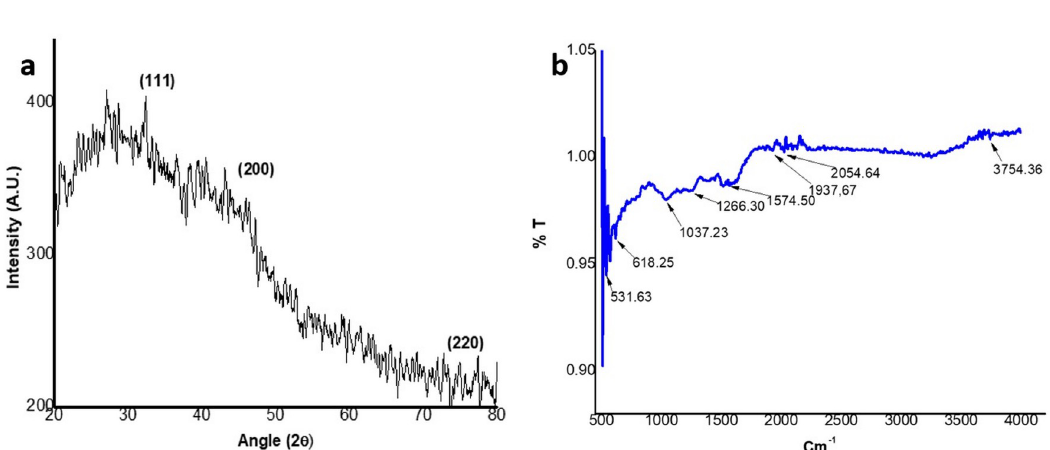
Fig 3. Characterization of CuNPs. (a) XRD pattern of CuNPs, predicting crystalline nature of CuNPs; (b) FTIR spectrum of CuNPs, confirming functional groups from plant extract capping the CuNPs.